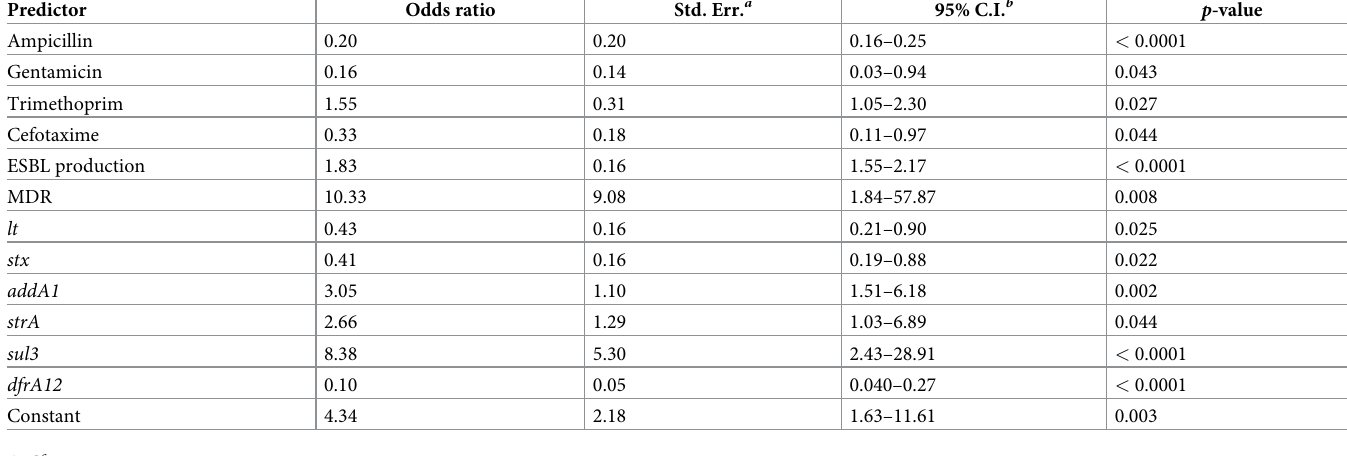
Table 7. Logistic regression model of the association between E . coli resistance to sulfamethoxazole and resistance phenotype, resistance gene, and virulence genes ( n = 409) classified by type of samples.